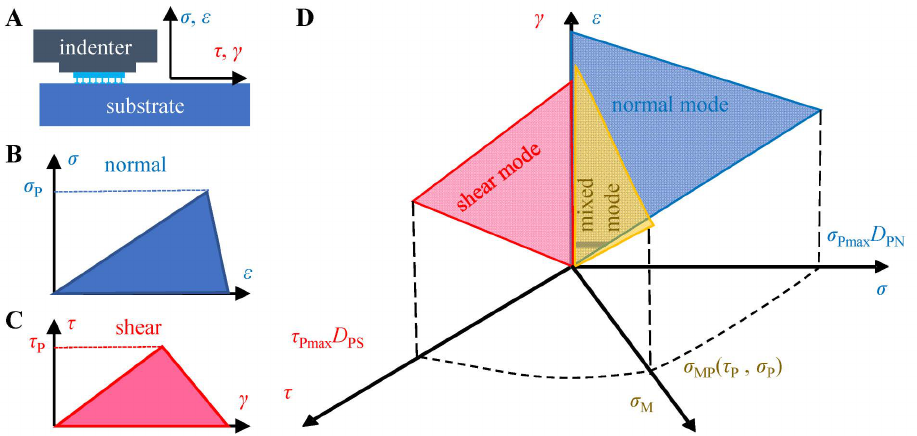
Figure 2. ( A ) Interfacial action during pull-off of the bioinspired adhesives; ( B ) normal and ( C ) tangential bilinear CZM models considering precompression strength; ( D ) two-dimensional coupled CZM model with precompression strength